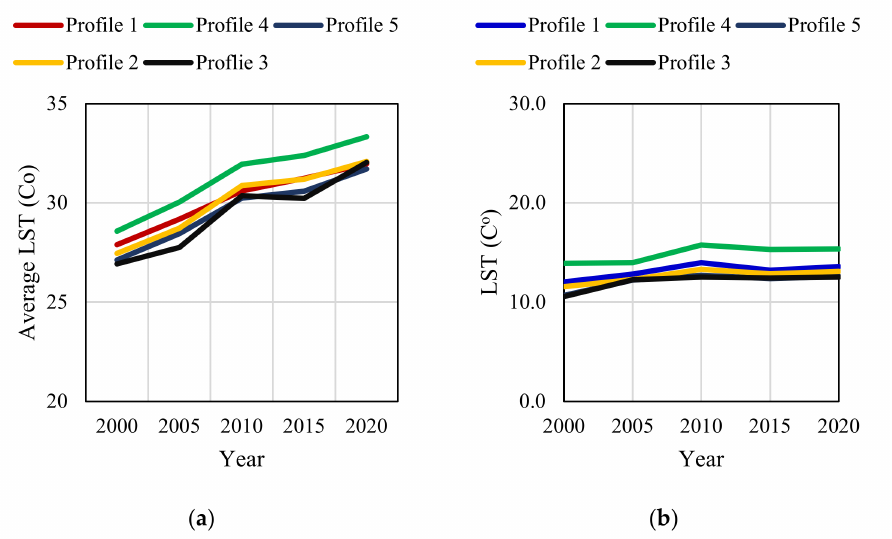
Figure 21. Average Nighttime LST in Summer and Winter across the Three Profiles. ( a ) Average Nighttime LST in Summer; ( b ) Average Nighttime LST in